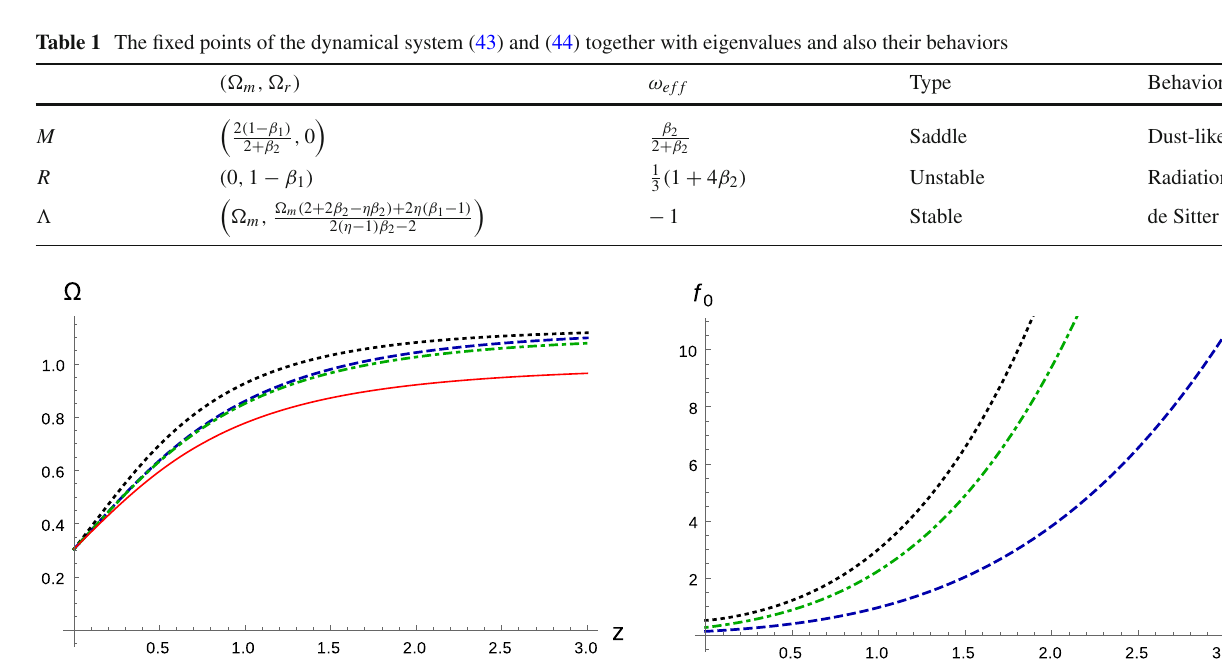
for the model parameters presented in Table 2. For the Hubble parame- ter, we have also plotted te experimental data together with their errors [46]. The (cid:2) CDM curve is depicted as a red solid curve